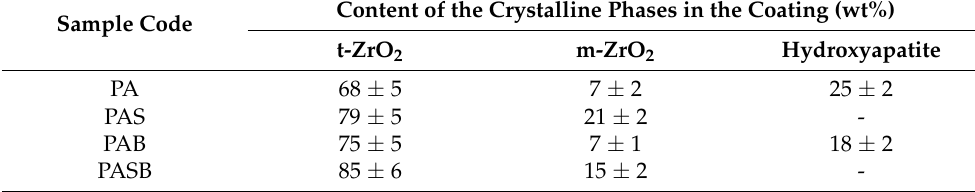
Figure 6. X-ray diffractogram of the PA, PAS, PAB, PASB-coatings after the SBF test.